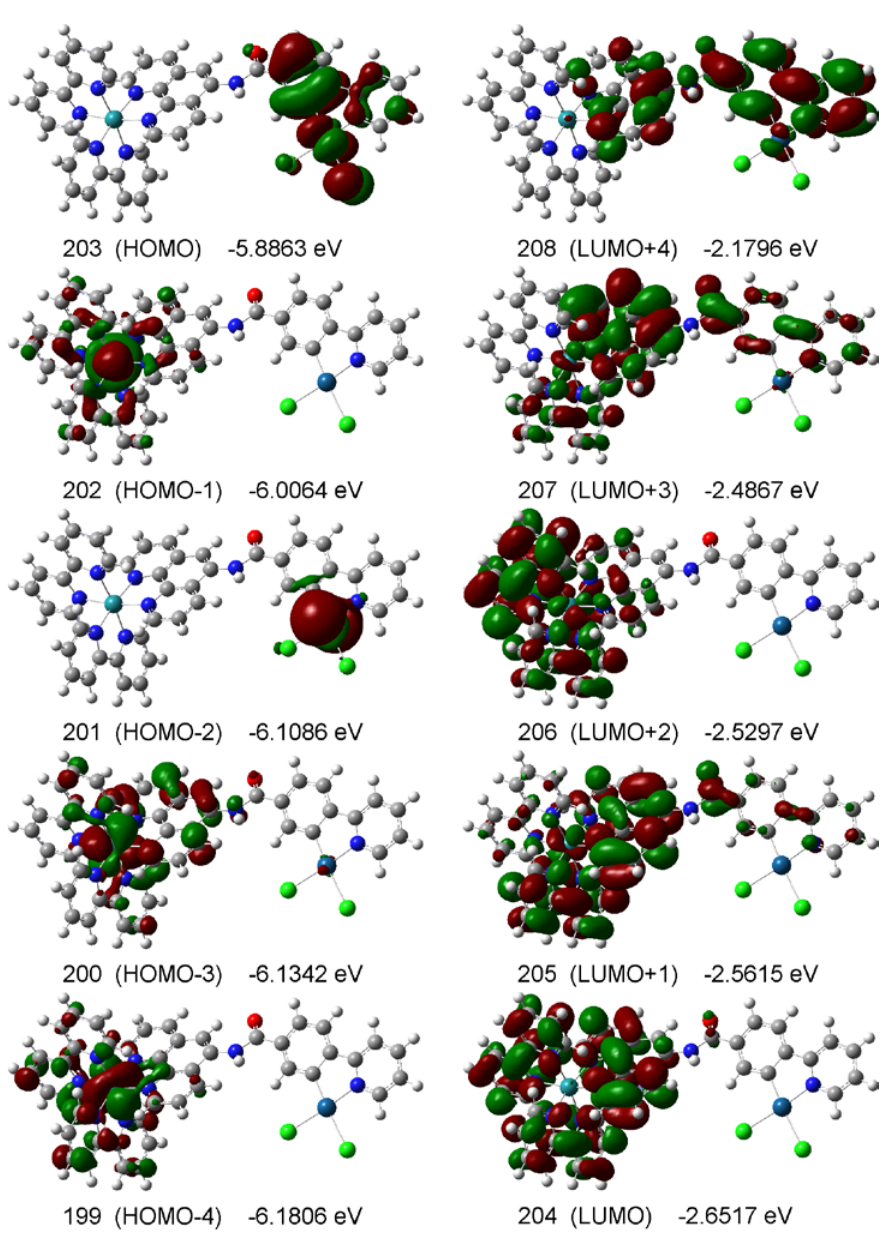
Figure 5. Frontier molecular orbitals of a fully optimized structure of conformer 2a for 2 in water, where the structure was computed at the B3LYP level of DFT using the LanL2DZ base set, using the PCM